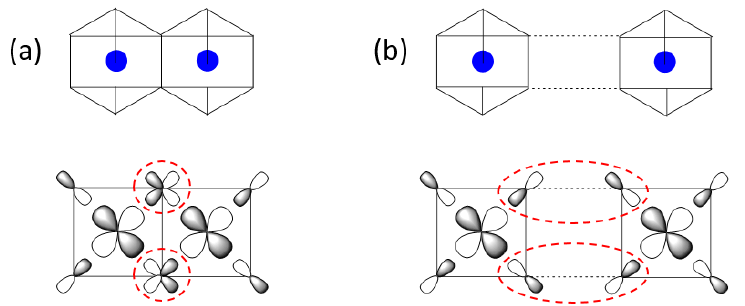
Figure 6. Arrangement of two x 2 − y 2 magnetic orbitals ( a ) in the first NN exchange path and ( b ) in the third NN exchange path in a honeycomb lattice of magnetic ions. In ( a , b ), the two magnetic orbitals interact through their p-orbital tails in the circled regions. The NiO 6 octahedra are presented to emphasize the square planes containing the x 2 − y 2 magnetic orbitals.